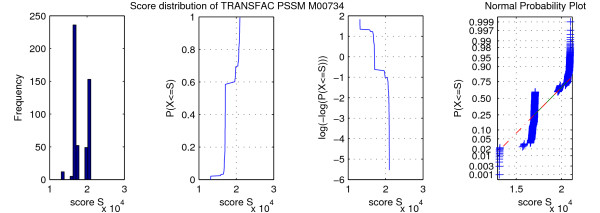
Score distribution of TRANSFAC PSSM M00734. Histogram, cumulative score distribution function, X-Y plot, and normal probability plot of TRANSFAC PSSM M00734 (PSSM length m = 9).